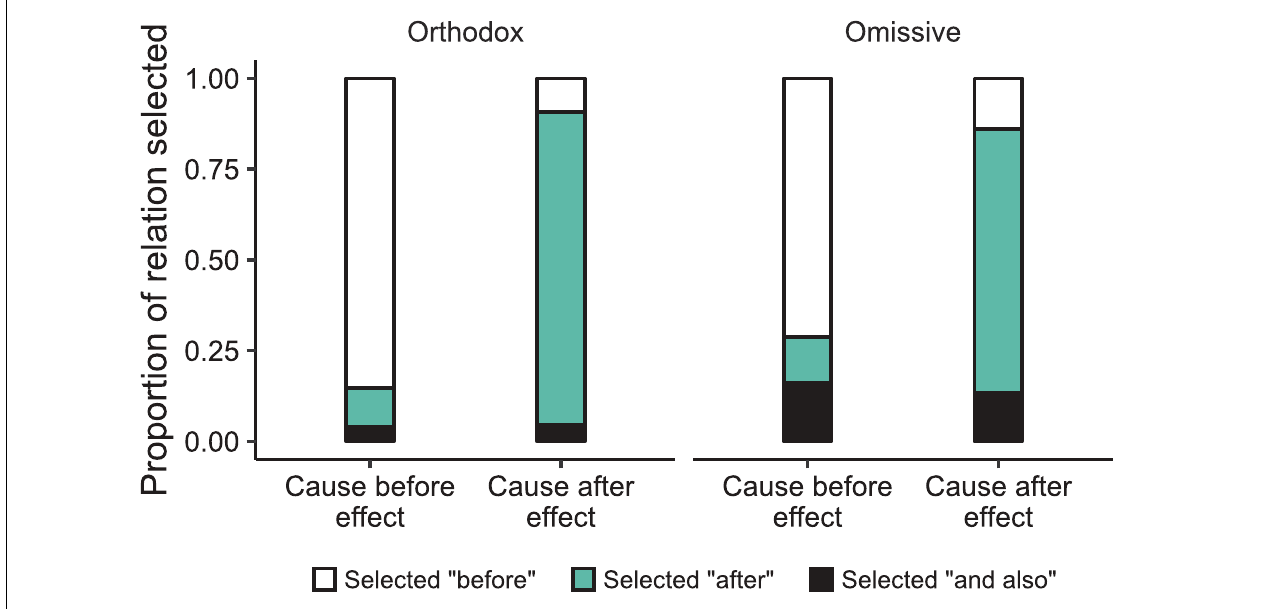
FIGURE 2 | Proportions of participants’ selections of the three different types of relations in Experiment 2 as a function of whether the incomplete assertion described a cause that occurred before or after the effect for both orthodox and omissive